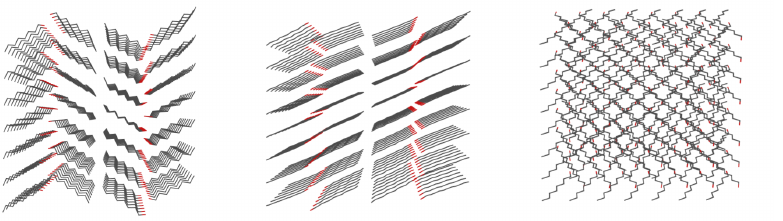
Figure 2. n-octanol molecules cluster used in classical dynamics experiment, as visible along different axes—on-plane ( left ), in-plane ( center ), and cross-plane axes ( right